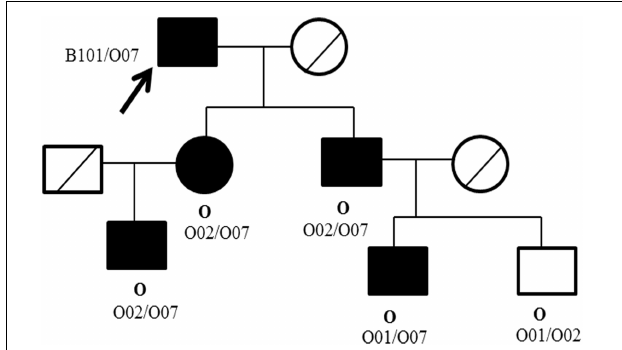
FIGURE 2 | Pedigree of the ABO phenotype and genotype of the proband and family members. The ABO phenotype is in bold (above), whereas the genotype is in plain text (below). (cid:3) Male; (cid:13) Female; allele; (cid:30) Samples not acquired; (cid:37) The proband.